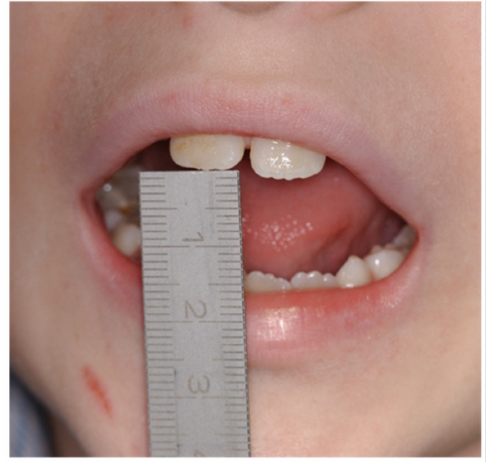
Figure 1. Reduced mouth opening (13 mm) at the first visit (age